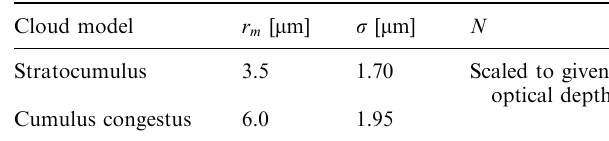
Table 1. Microphysical parameters of cloud models. The droplet size distributions for the two models stratocumulus and cumulus congestus as proposed by McCartney (1976) are approximated using lognormal distributions. The respective relative distribution is obtained from mode radius r and standard deviation r , while m droplet number concentration N is scaled to the prescribed